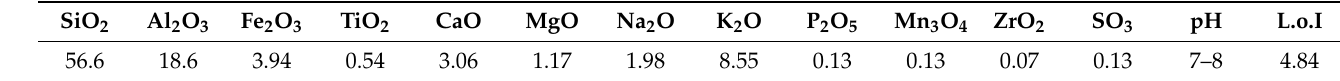
Table 1. Chemical analysis (expressed in wt% oxides) with loss on ignition (L.o.I) and pH value of pumice